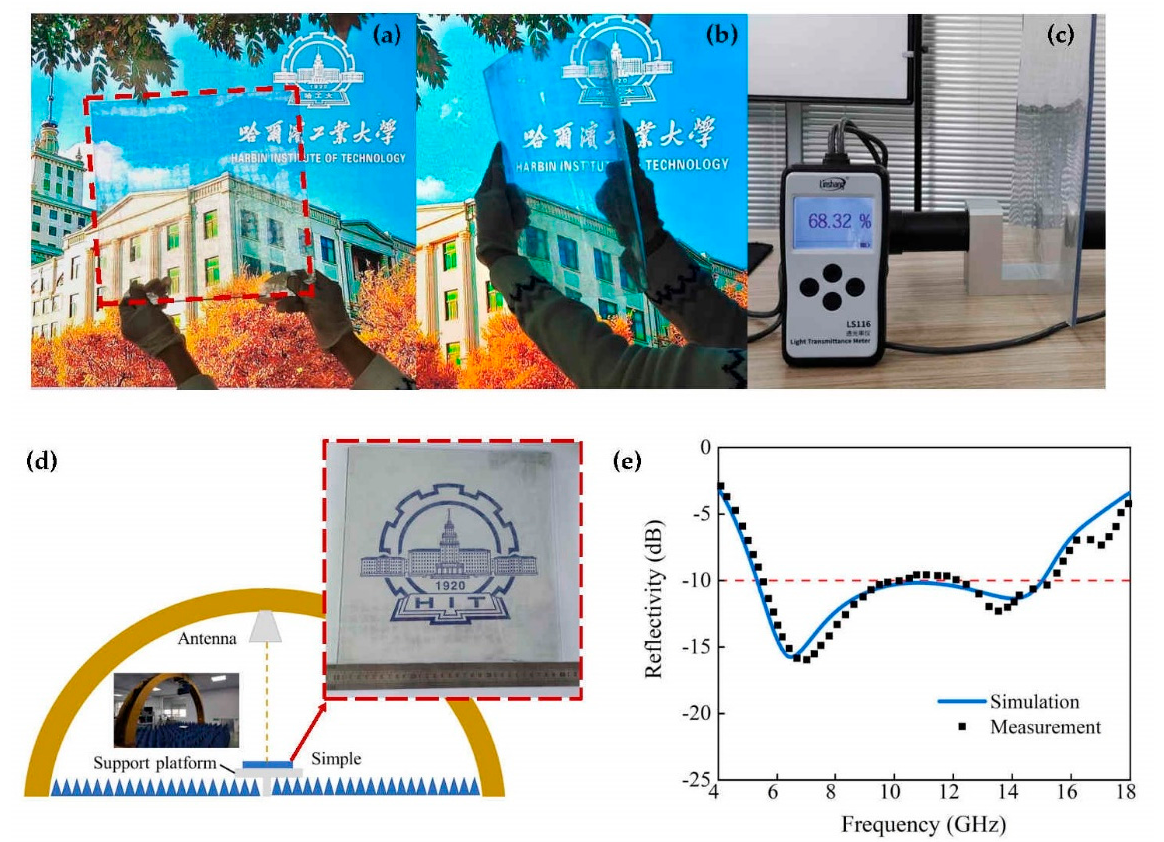
Figure 8. Photos of the fabricated ( a ) FTBMA and ( b ) bent FTBMA with great flexibility. ( c ) Transparency measurement of FTBMA. ( d ) Schematics of setups for measurement of reflectance. Inset: photograph of the fabricated FTBMA. ( e ) Comparison of measured and simulated reflectivity for FTBMA.